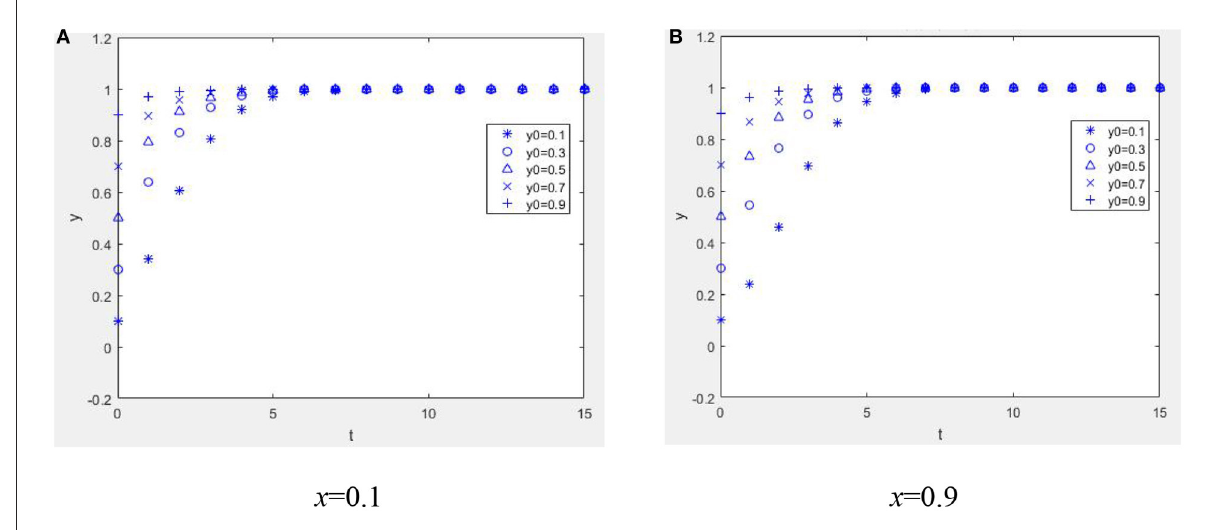
FIGURE2 Dynamc evolution diagram under Case 1. (A) x = 0.1 and (B) x = 0.9.